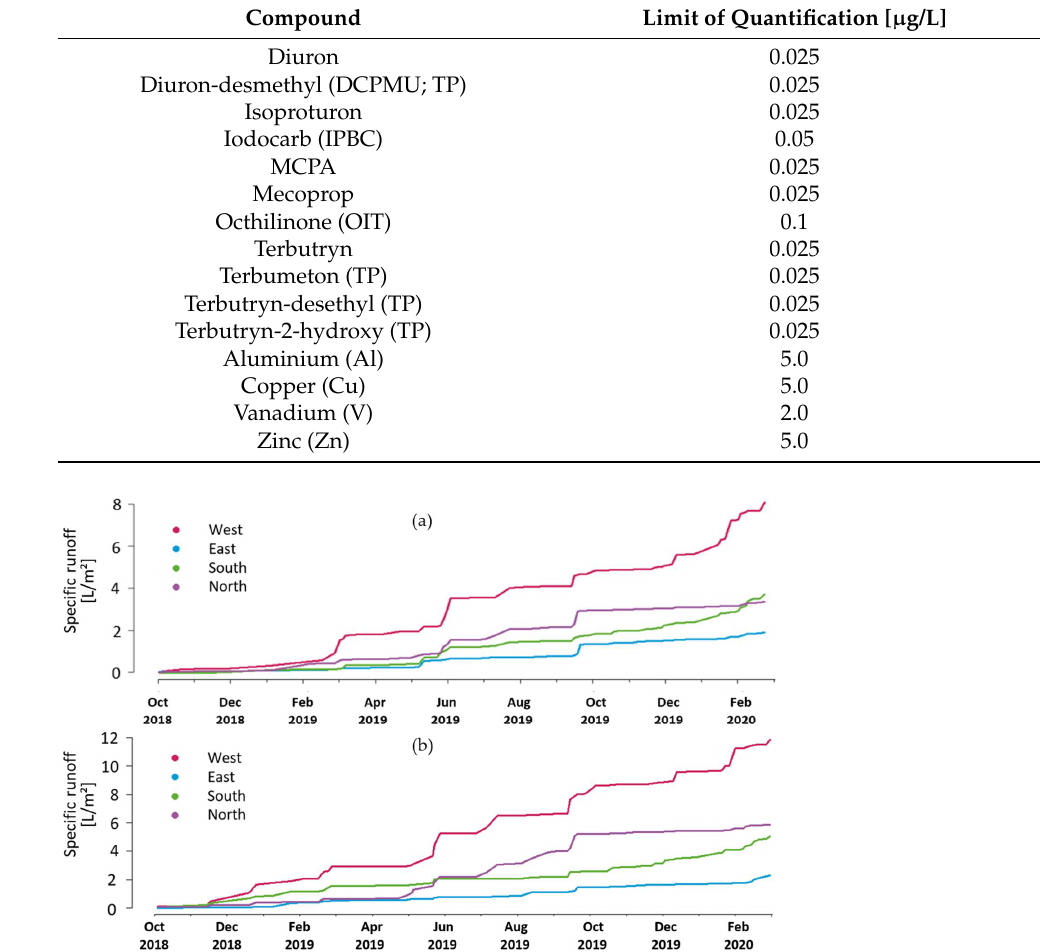
Table A1. Limits of quantification (LOQ) of analysed compounds; TP—transformation product.